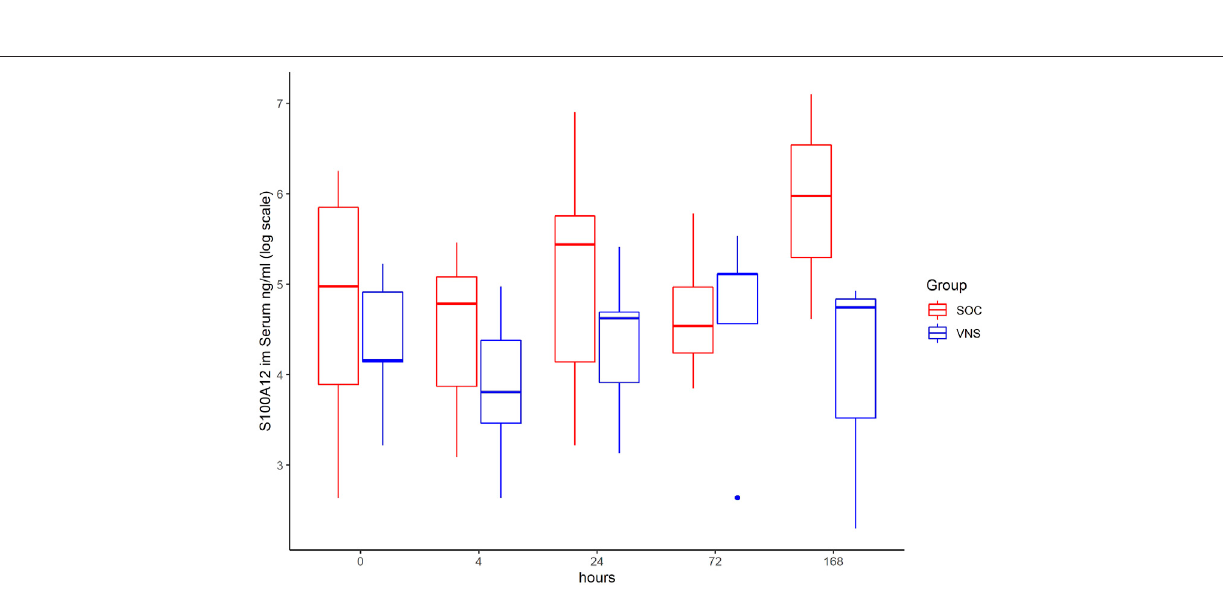
Frontiers in Physiology |